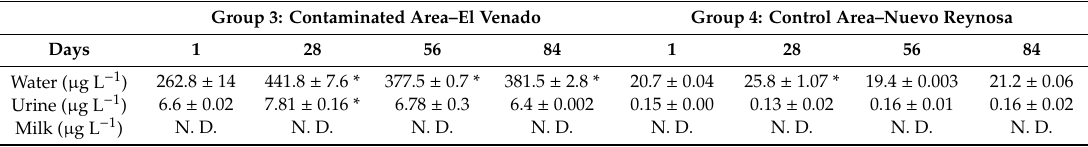
Table 4. E ff ects of arsenic on female Creole goats of Groups 3 vs. 4.